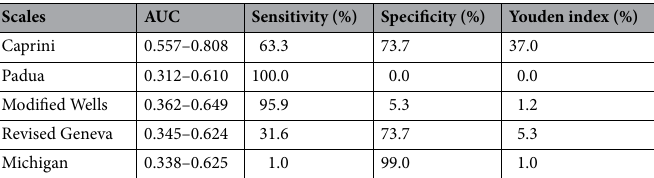
Table 3. Comparison of the five different thrombosis risk assessment scales in predicting the occurrence risk of CRT in patients with hematological cancers.